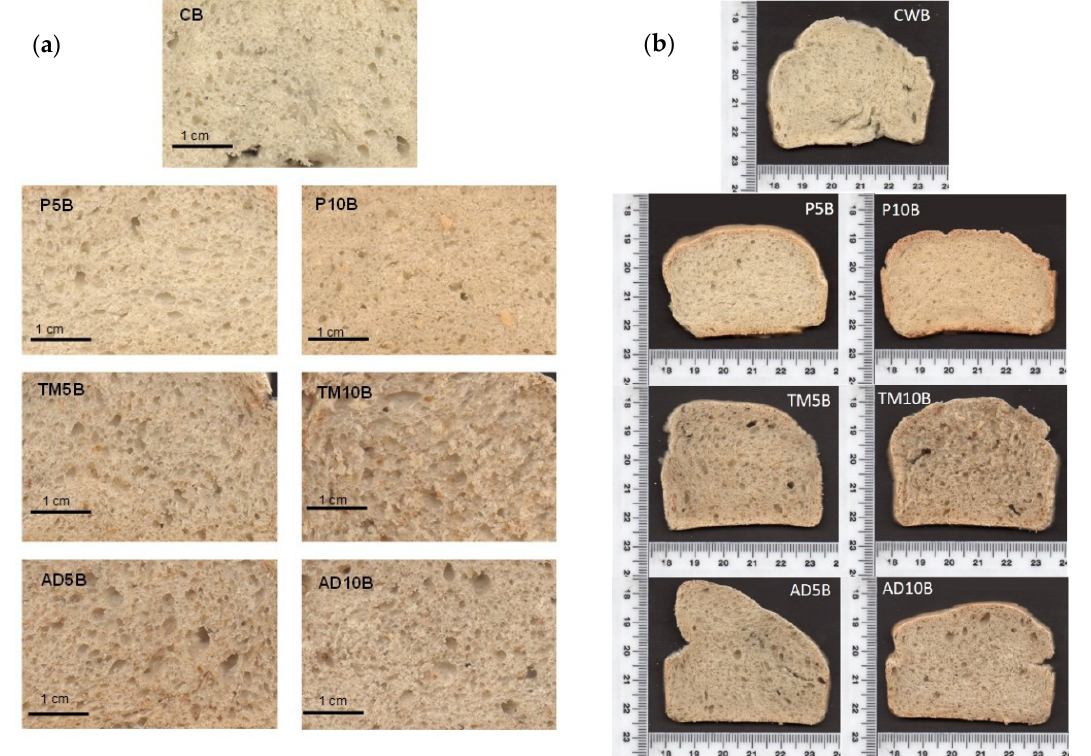
Figure 2. Digital analysis images of bread crumb ( a ) and cross-section ( b ) of bread made with alternative proteins. CWB: Control Bread; P5B: Pea 5% Bread; P10B: Pea 10% Bread; TM5B: T. molitor 5% Bread; TM10B: T. molitor 10% Bread; AD5B: A. diaperinus 5% Bread; AD10B: A. diaperinus 10% Bread.